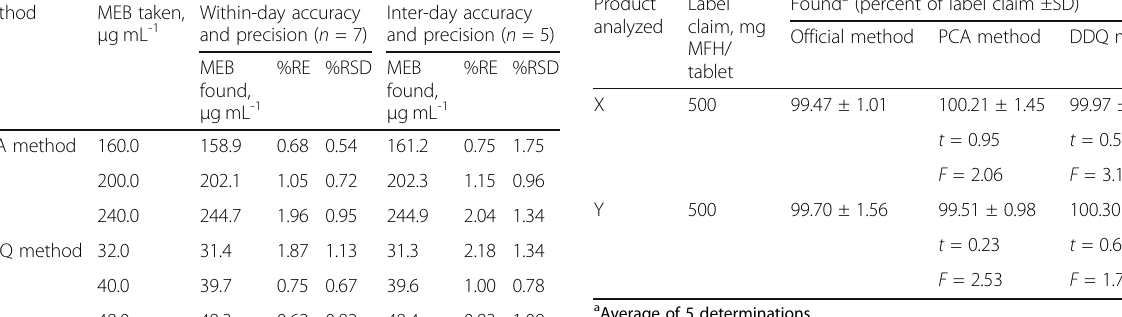
Table 3 Results of study of repeatability and intermediate accuracies and precisions of proposed methods Method